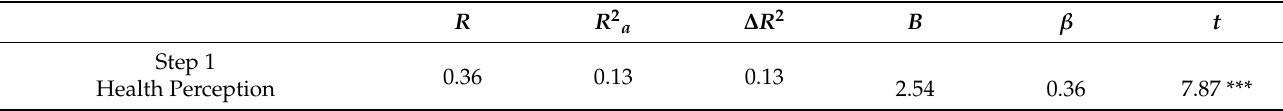
Table 4. Stepwise multiple regression analysis explaining